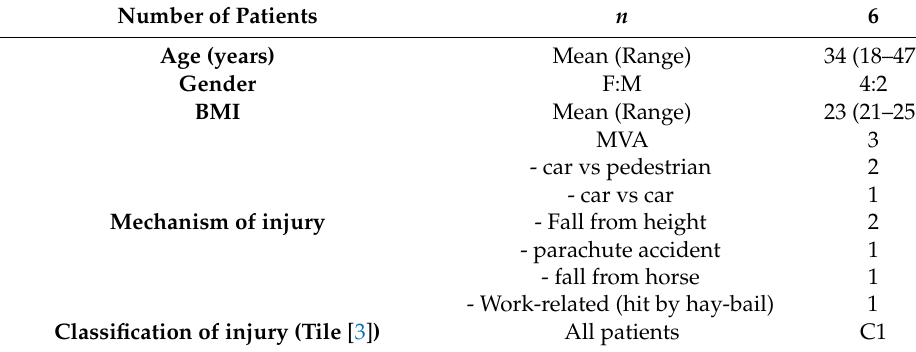
Table 1. Patient and injury